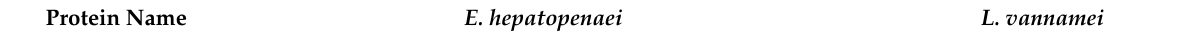
Table 2. Total amino acid residues present in the binding pockets of different proteins of EHP and L. vannamei